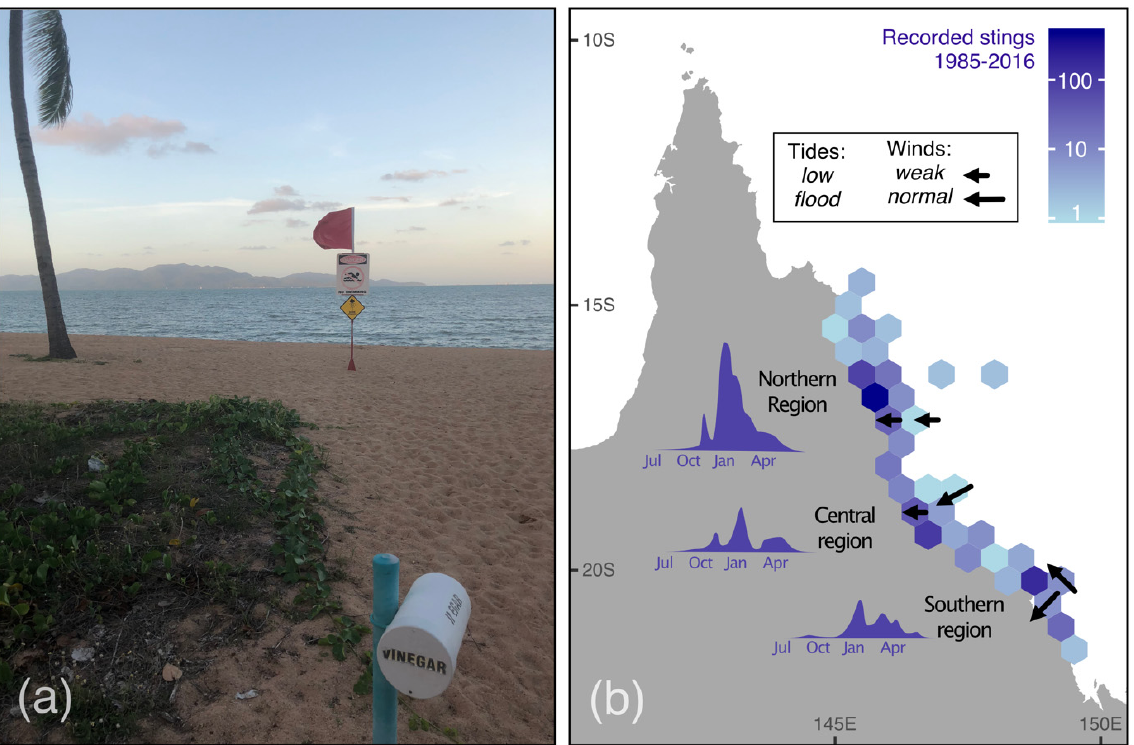
Figure 11. ( a ) Beach closure on the northern Great Barrier Reef (Photograph: S. Condie). ( b ) Geo- graphical distribution of Irukandji stings on the Great Barrier Reef and adjacent coast. There are sting hotspots where swimmers are most common. Also shown are seasonal patterns for the three main tourism regions, with stings peaking in late December and January, or slightly later to the south. Prevailing wind conditions over the few days prior to stings tend to be directed onshore and favour downwelling circulation.